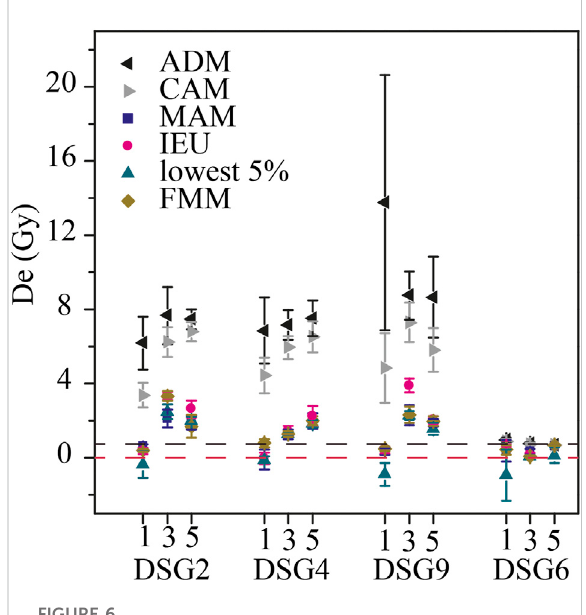
FIGURE 6 Comparation of different models D e s from the four samples with 1-, 3-, and 5-mm